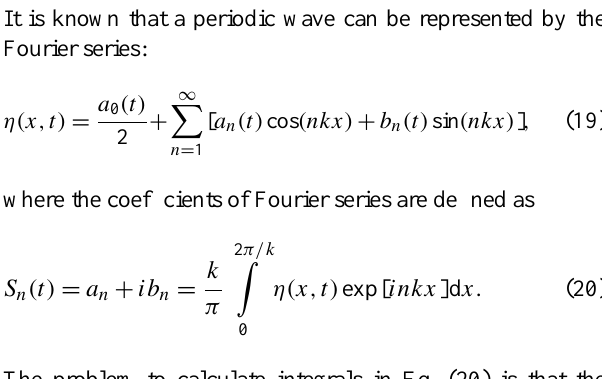
Figure 5. Nonlinear wave deformation for different signs of cubic nonlinearity. A = 2, t = 0.06. Qualitatively the same character of nonlinear deformation is obtained for strongly nonlinear interfacial waves (Sakai, and Redekopp, 2007; Zahibo et al, 2007), where the cubic nonlinear term is always negative.